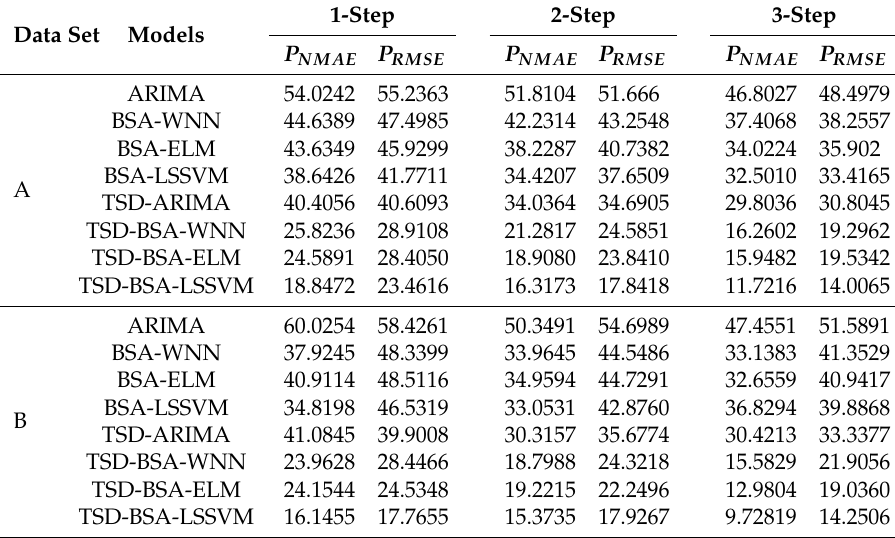
Table 4. The improved normalized mean absolute error (NMAE) and normalized root-mean-square-error (NRMSE) P NMAE and P NRMSE of different forecasting models compared with the proposed model